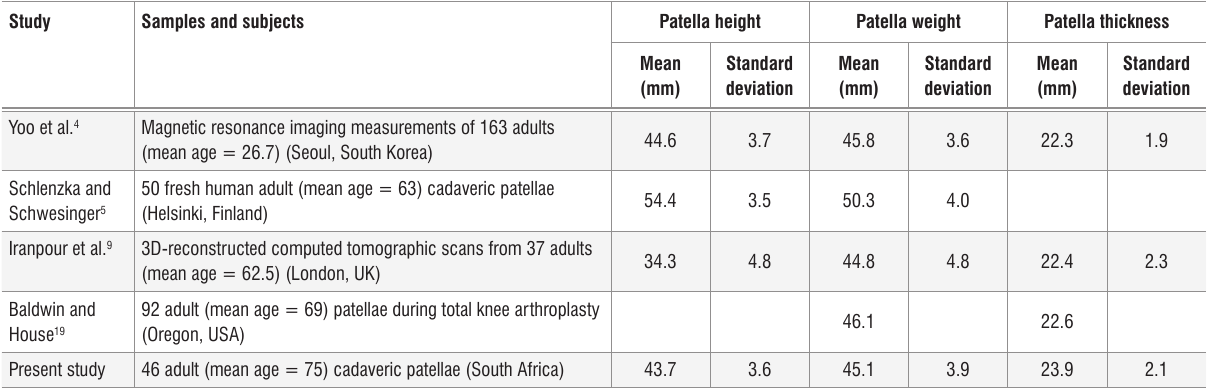
Table 6: Summary of studies which report patella dimensions Study Samples and